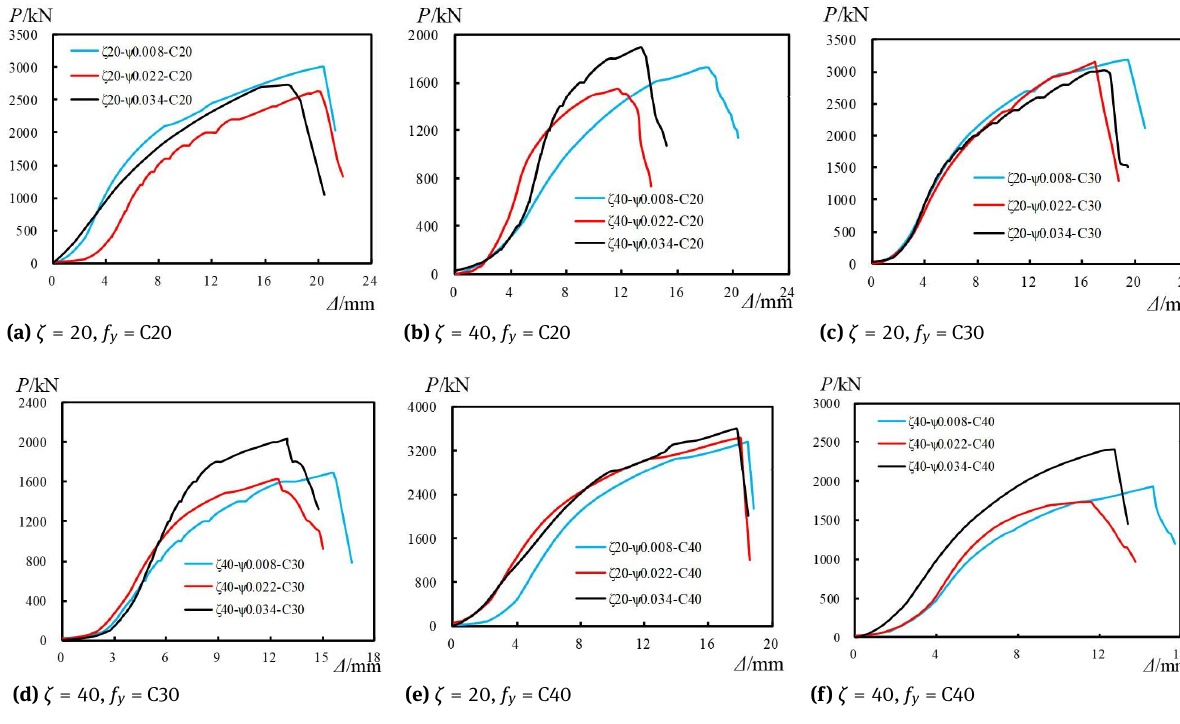
Figure 13: Typical load-displacement curves under different steel ratio